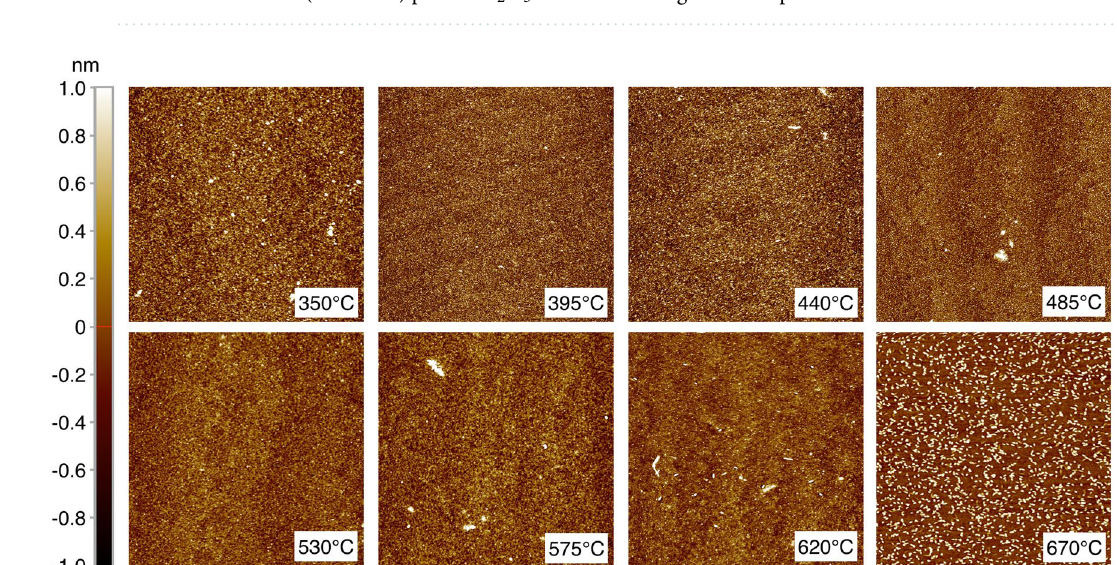
Figure 3. 5 µ m × 5 µ m AFM images of the temperature series. Note, the color bar on left corresponds to all ◦ images except for 670 C, where the scale is from ± 4 nm instead of ± 1 nm. An overview of the RMS roughness value determined from the AFM scans is given in Fig.